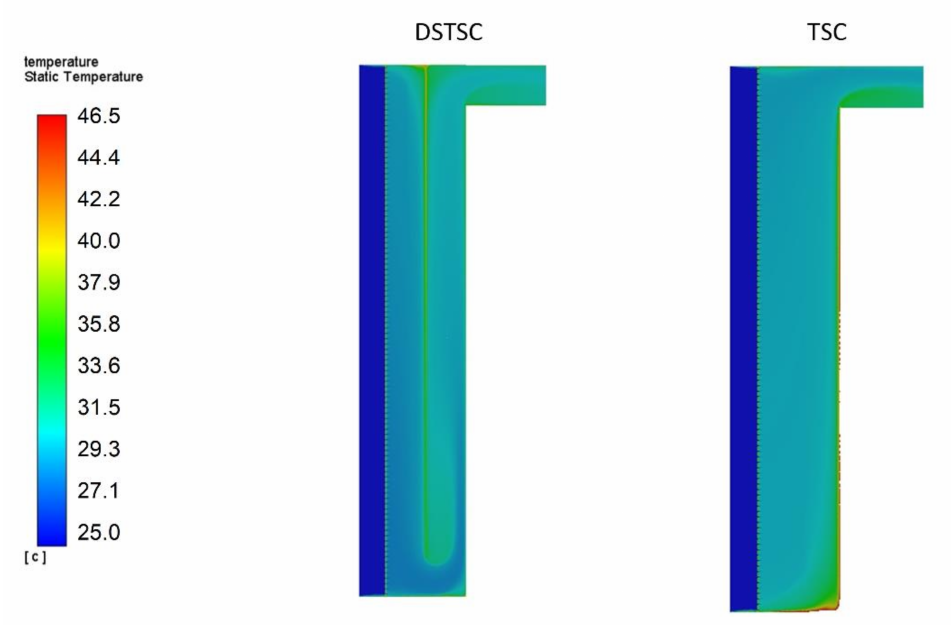
Figure 10. Temperature distribution in a median plane for the DSTSC ( left ) and TSC ( right ) at an air flow of 500 m 3